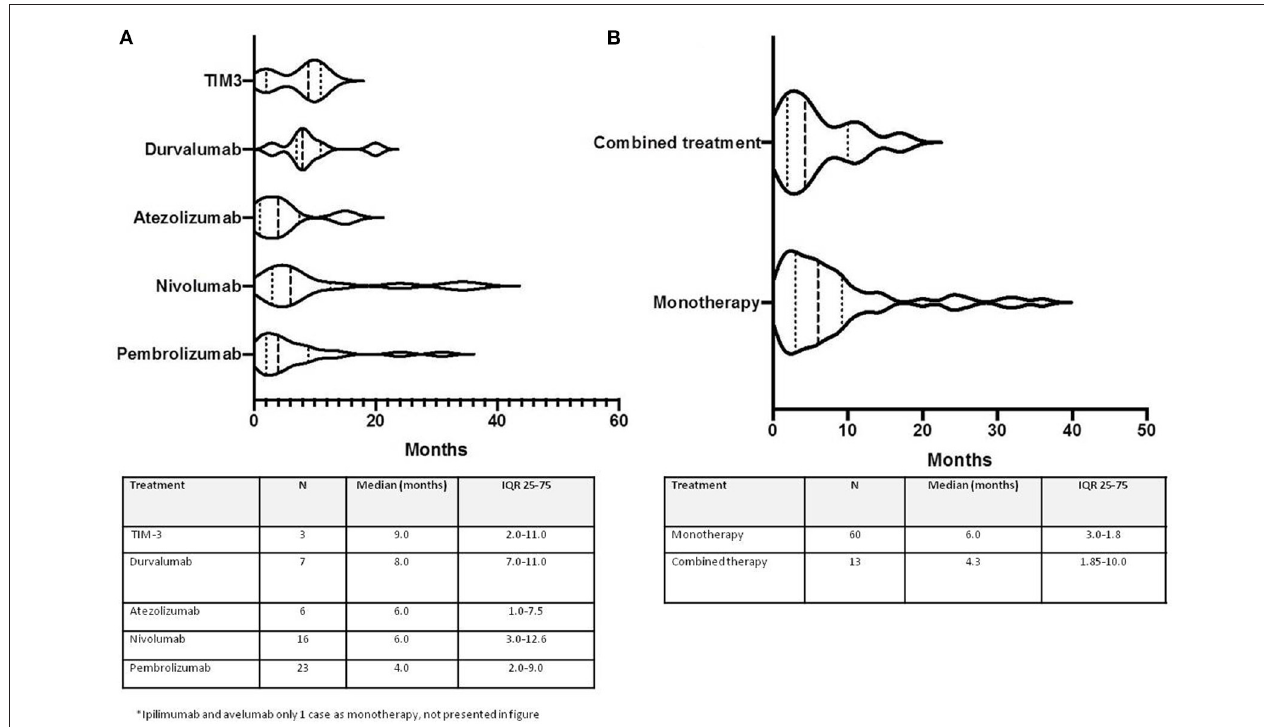
FIGURE 2 | Time to onset from ICI initiation and Rheumatic irAEs according treatment. (A) Type of treatment; (B) Monotherapy vs.